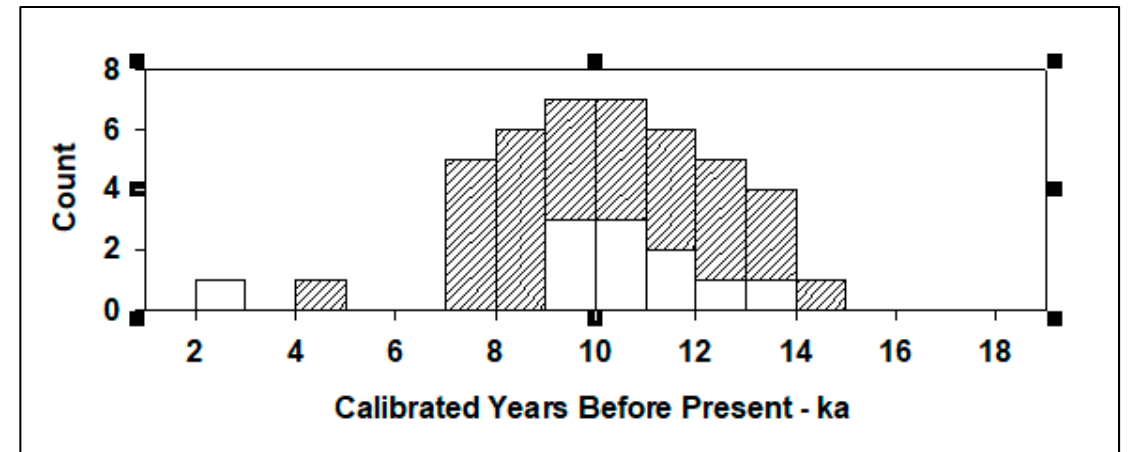
Figure 10. Histogram of basal peat dates for lake satellite fens (diagonal pattern, n = 32) and Moosehorn moraine fens (white bars, n = 11) in the study area.